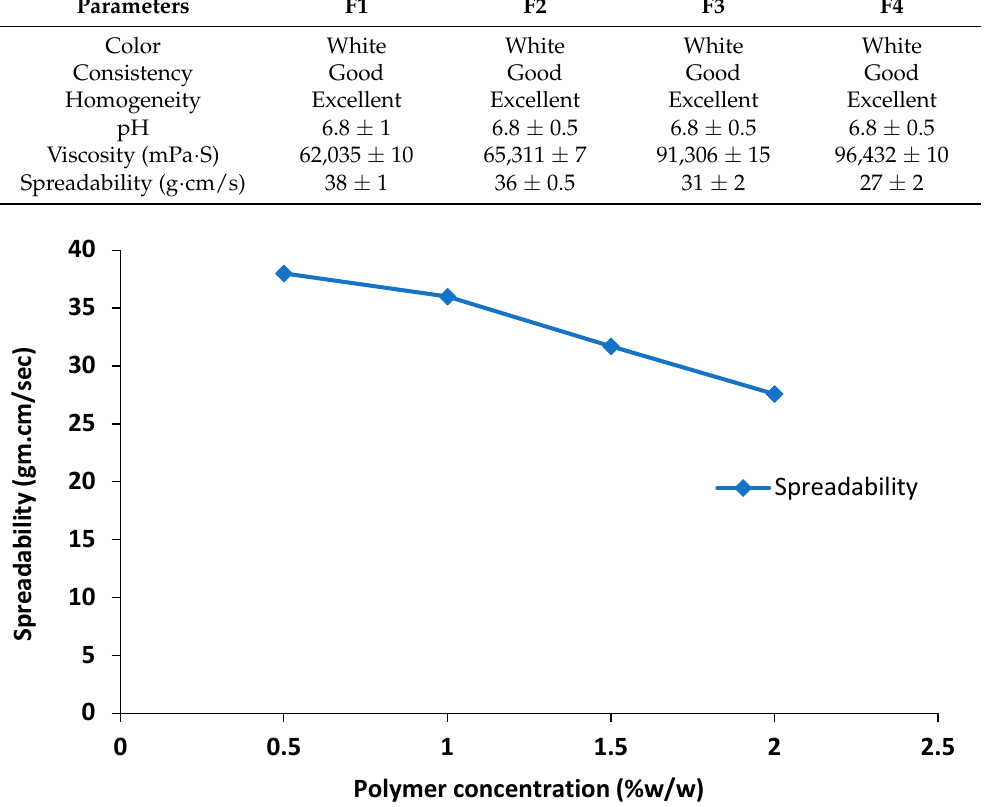
Figure 2. Effect of polymer concentration on spreadability of nanoemulgel.